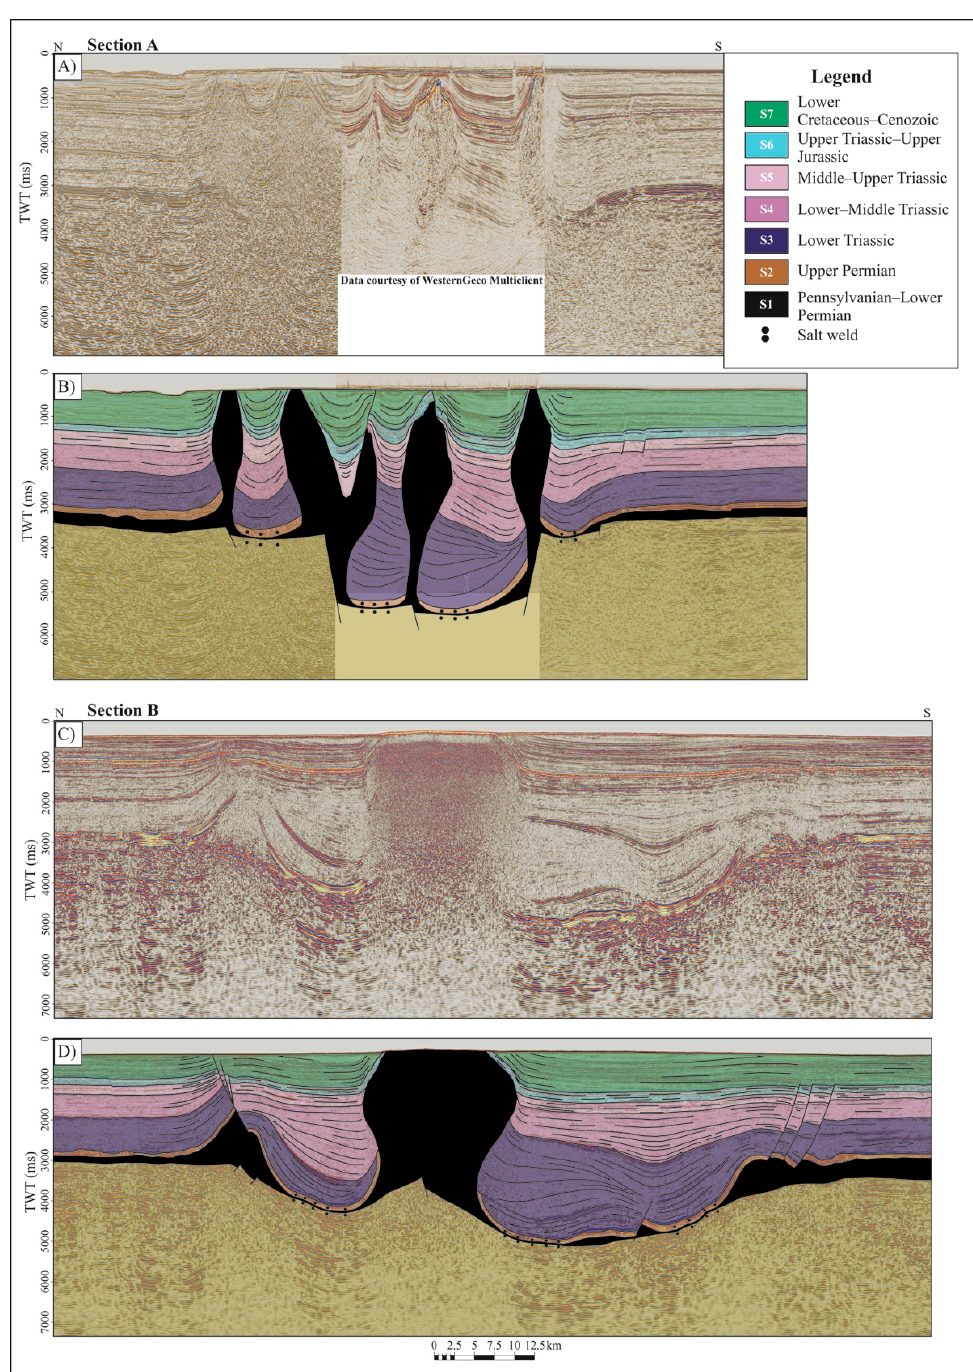
Figure 2. ( A ) Uninterpreted seismic section A across the central sub-basin. The central seismic panel is from a higher-resolution, full azimuth seismic data provided by WesternGeco Multiclient. ( B ) Interpreted section A. The base salt was estimated based on parallel seismic sections that extend to 7000 ms. ( C ) Uninterpreted seismic section B across the eastern sub-basin. ( D ) Interpreted section B. Legend shows the interpreted seismic units (Figure 1C). See figure 1B for location of these sections. Figures modified from Rojo et al. [18].